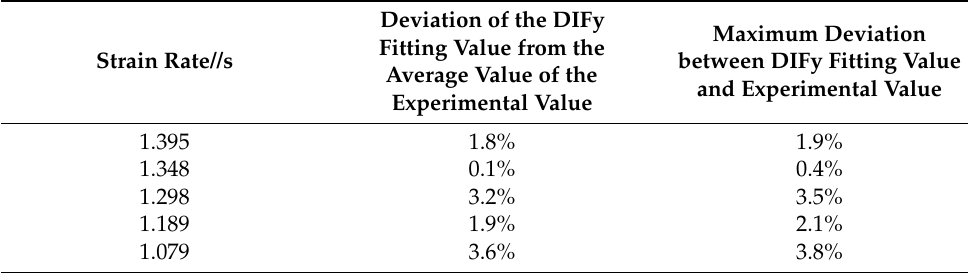
Table 7. Deviation analysis table of DIFy fitting value and experimental value. Deviation of the DIFy Maximum Deviation Fitting Value from the between DIFy Fitting Value Strain Rate//s Average Value of the and Experimental Value Experimental Value 1.395 1.8%